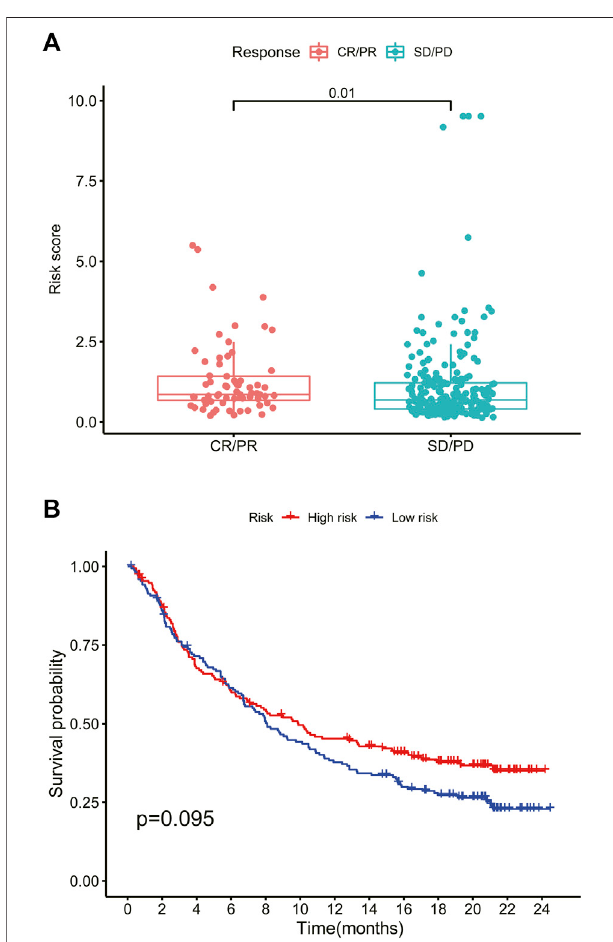
FIGURE11| High-riskscorespredictimmunotherapyresponse (A) Box plot of the effect of the high- and low-risk groups after immunotherapy (Wilcoxon test, p < 0.05) (B) Survival curve of the high- and low-risk groups afterimmunotherapy.CR,completeresponse.PR,partialresponse.SD, stable disease. PD, progressive disease (log rank test, p <